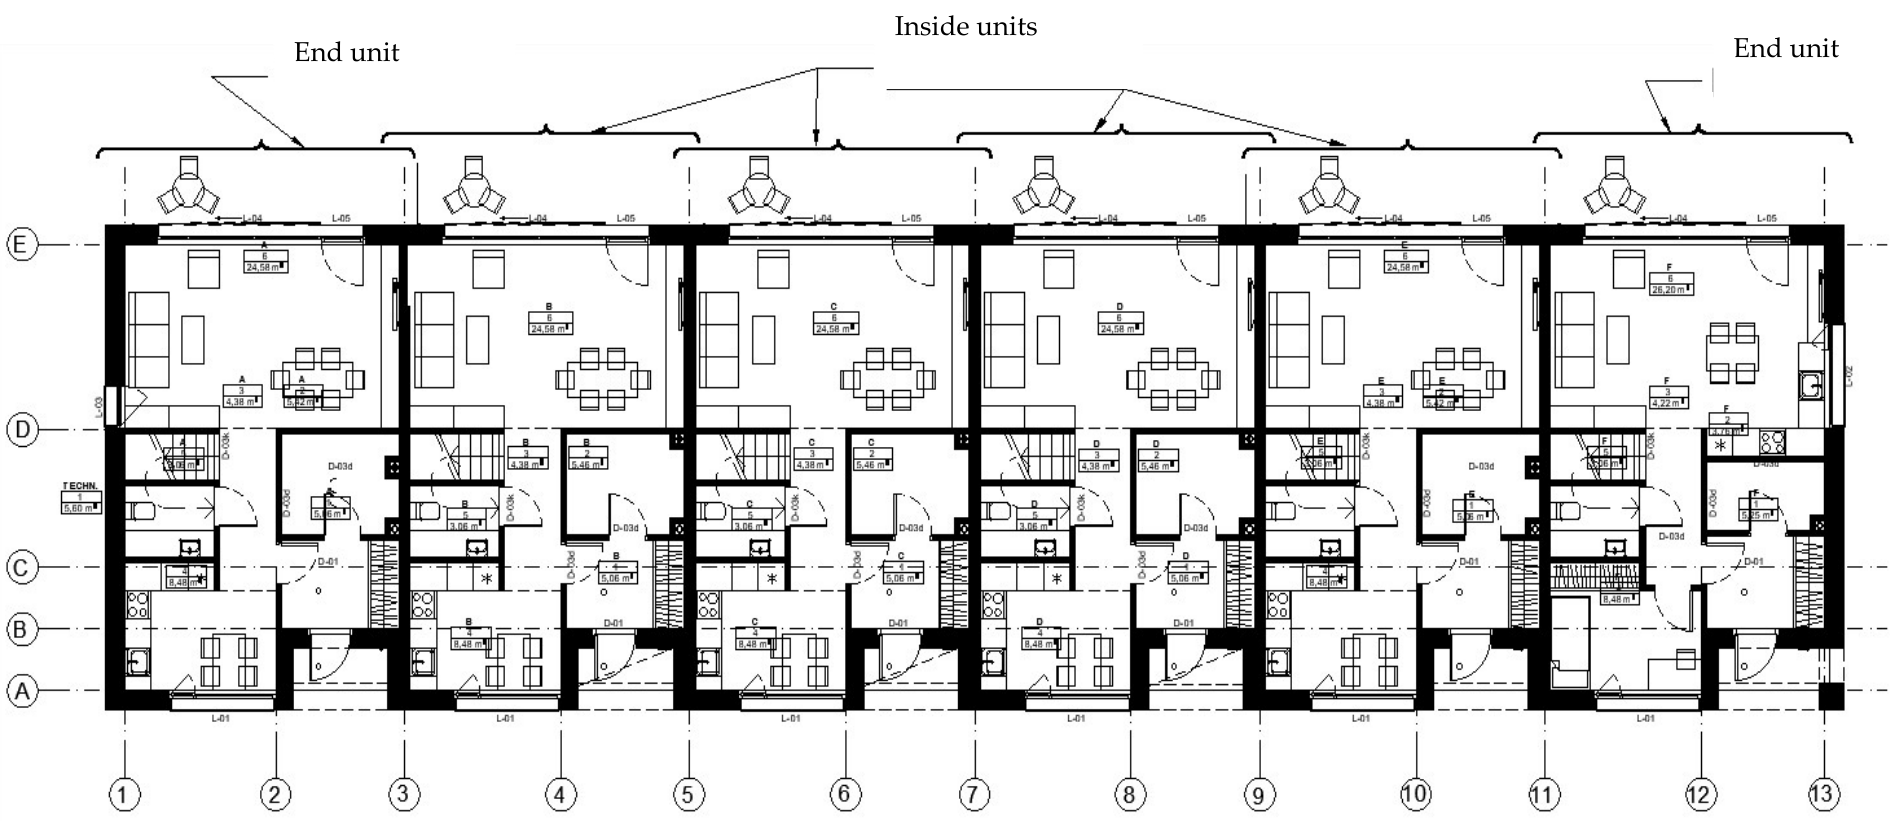
Figure 1. Architectural plan of building with specified types of the flats.